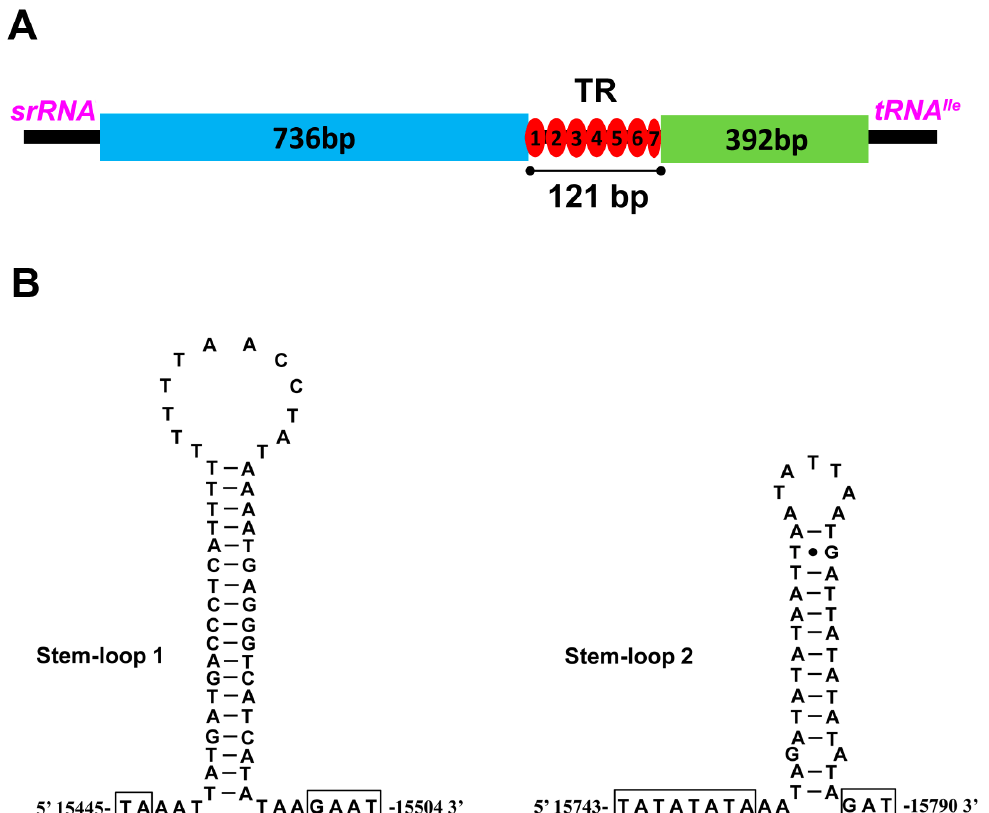
Figure 5. Control region of the S. teleckojensis mitogenome. ( A ) Structure elements found in the control region of S. teleckojensis . ( B ) Putative stem-loop structures found in the control region of S. teleckojensis . Two Stem-loop (SL) structures were predicted in the CR: SL1 (15,445–15,504) and SL2 (15,743–